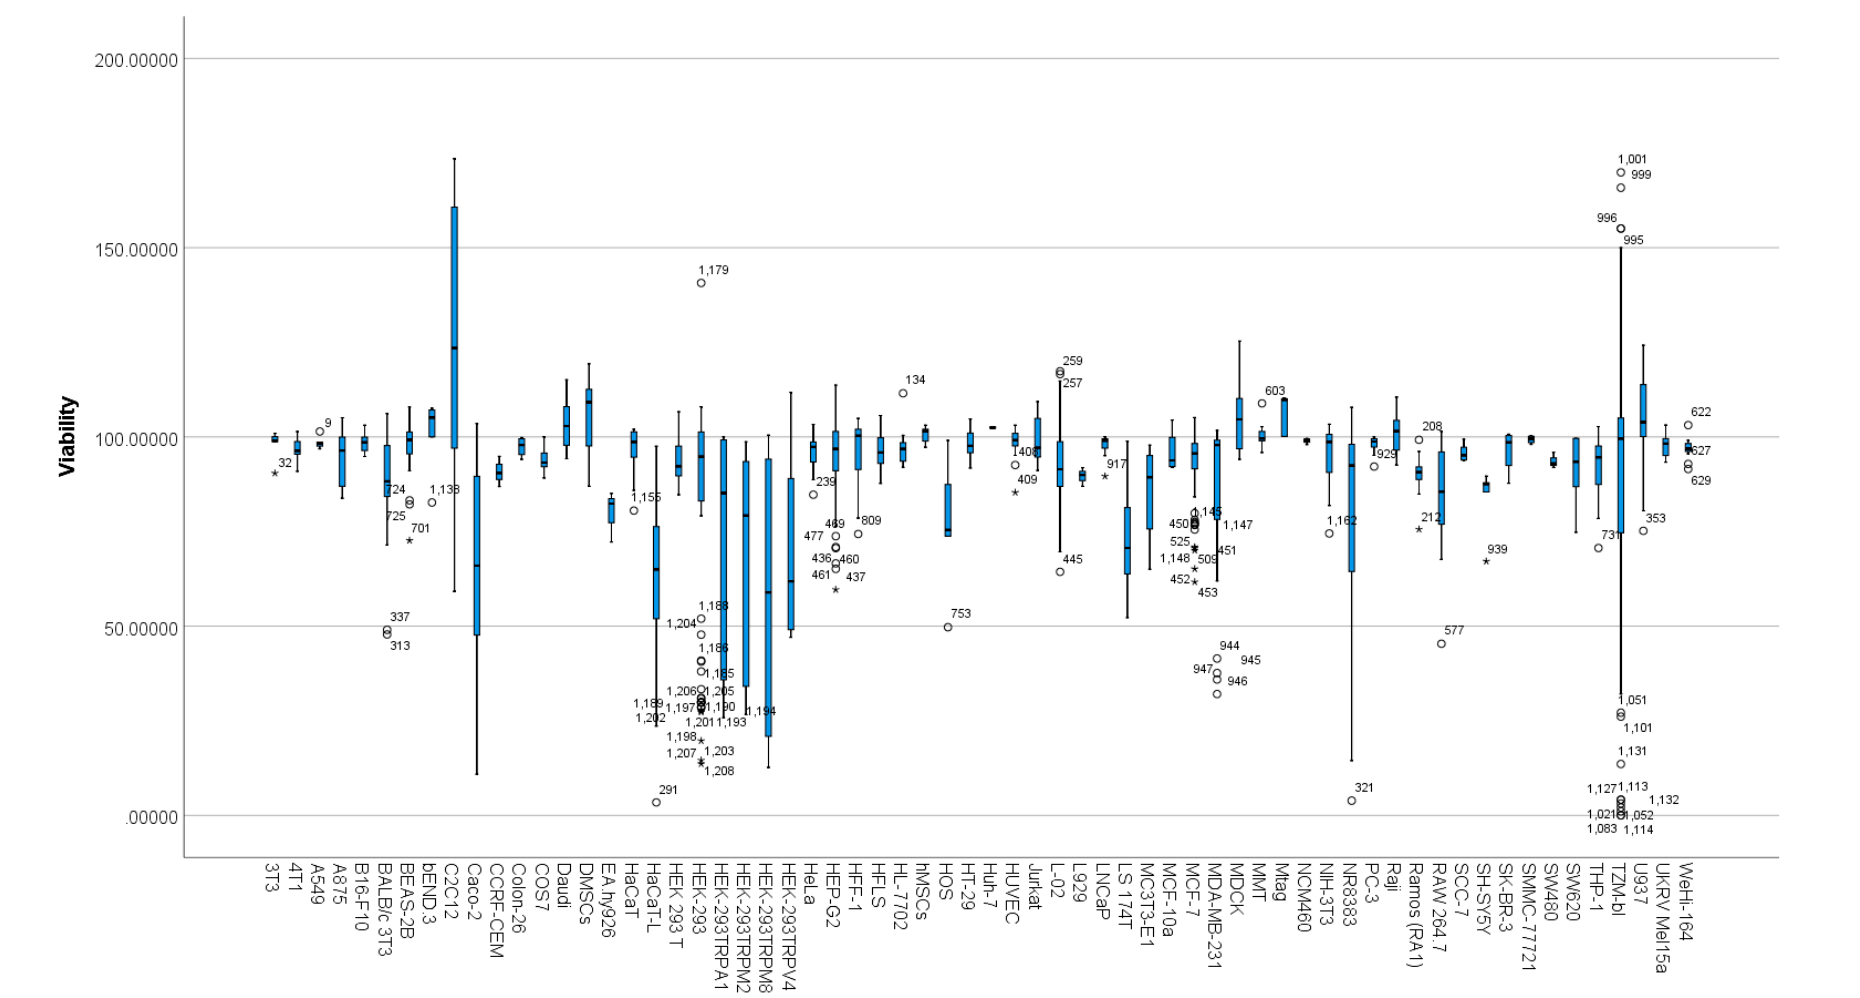
Figure 10. Distribution of viability across different cell types. The boxplot represents the distribution of viability across different cell types. Any data points that are more than 1.5 box-lengths from the edge of their (blue) box are classified by SPSS Statistics as outliers and are illustrated as circular dots. Data points that are more than 3 box-lengths away from the edge of their box are classified as extreme points (i.e., extreme outliers) and are illustrated with an asterisk (*).